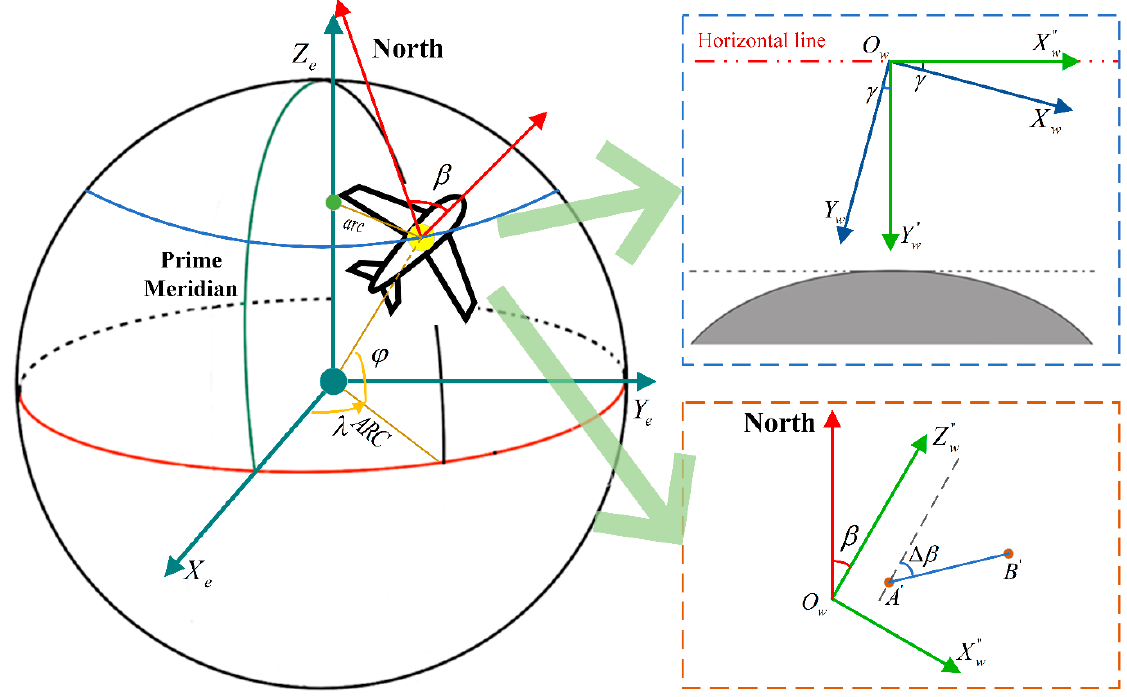
Figure 9. The geographic coordinate system and the world coordinates system.